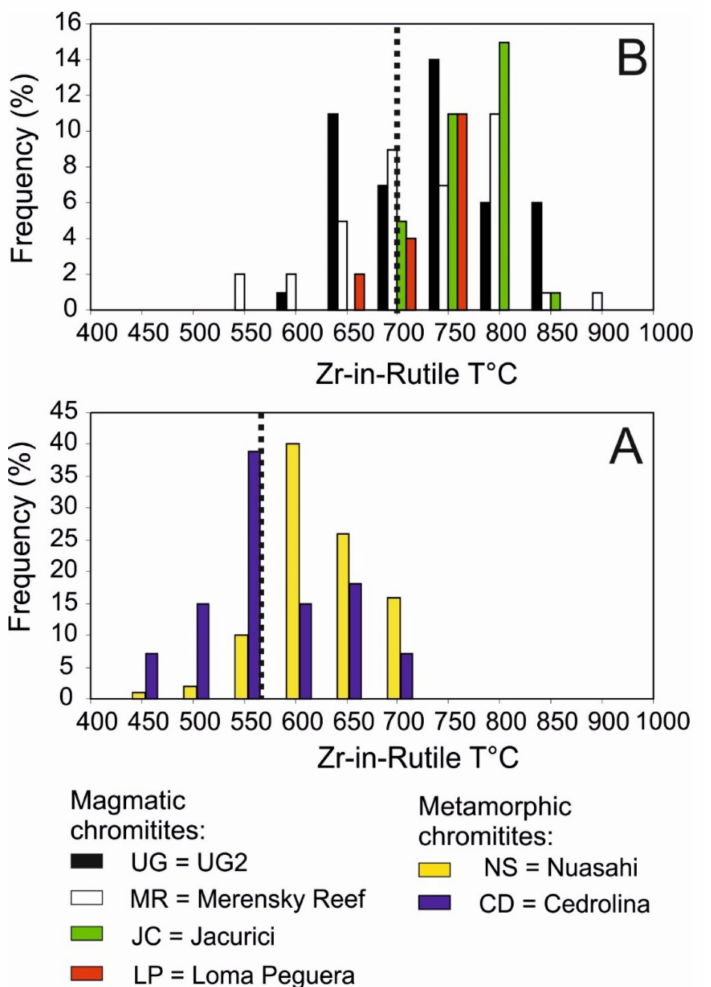
Figure 11. Frequency percent of Zr-in-rutile temperatures (degrees Celsius) calculated with the equation of [12] on a total of 328 grains. Thermal range and average (dotted line) of rutile in magmatic chromitites ( A ). Thermal range and average (dotted line) of rutile in metamorphic chromitite ( B